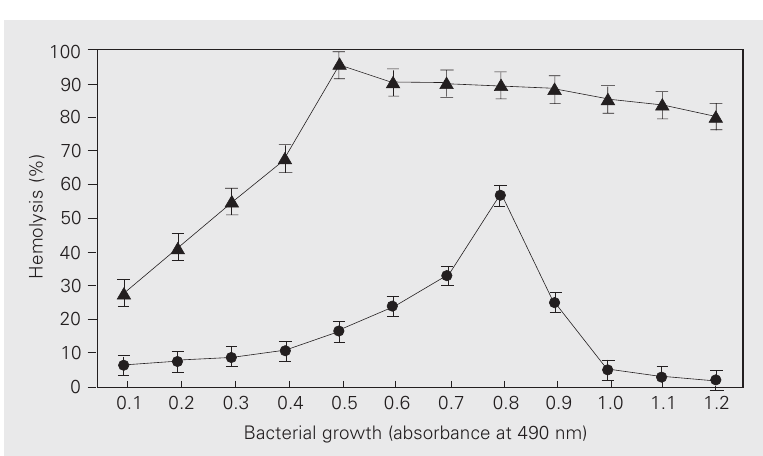
Figure 1. Effect of hns muta- tions on Serratia marcescens hemolysin expression. Hemoly- sis was measured by absorb- ance at 405 nm. C- = negative control, no bacteria added to cells (filled columns to the left of each column). MC4100 and MC41 = E. coli strains hns + and hns , respectively. CH946 and CH1839 = S. typhimurium hns + and hns , respectively. Each bar indicates the mean ± SEM of six independent experiments. The level of hemolytic activity was 2-fold lower in the two wild- type strains compared with the two strains harboring hns muta- tions (MC41 and CH1839). P < 0.001 (chi-square significance test).